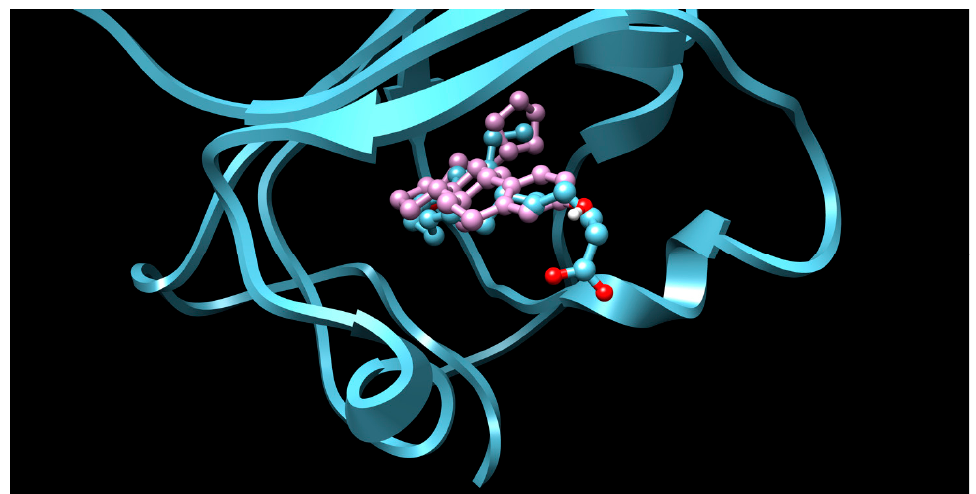
Figure 2. Superimposition of estradiol (pink) with linoleate (cyan) in the spike FABP.